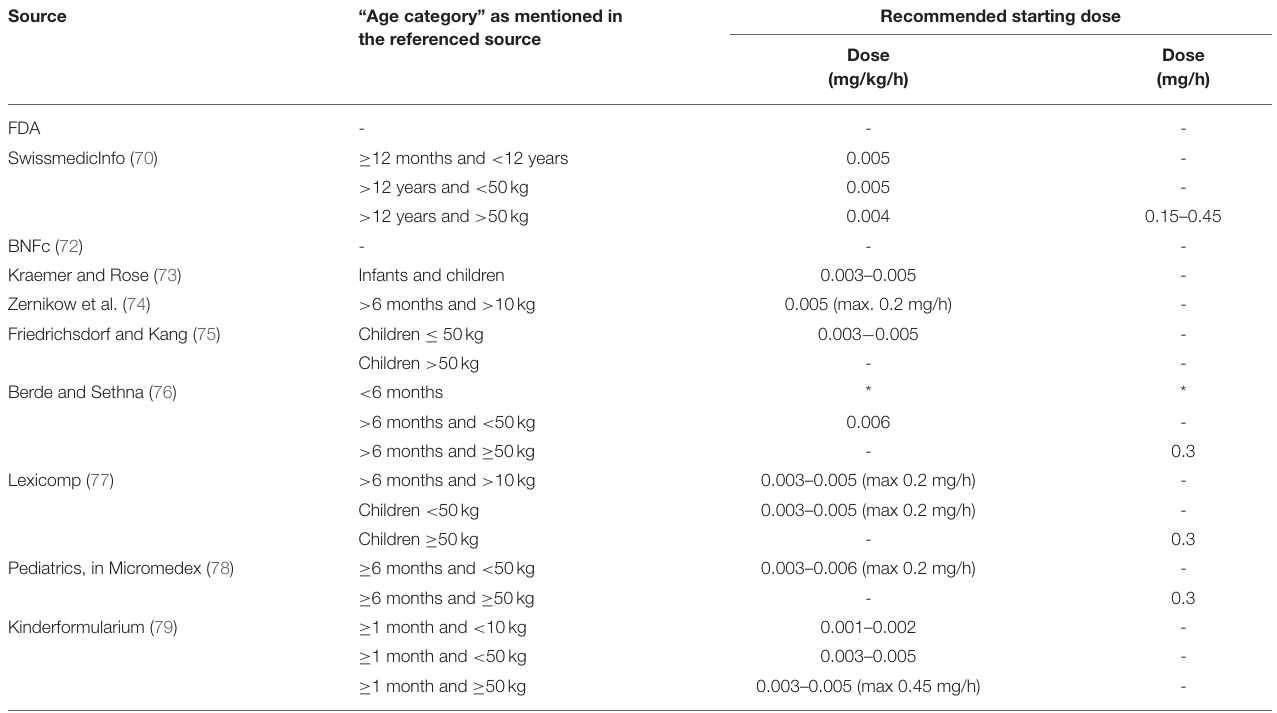
TABLE 3B | IV, Continuous